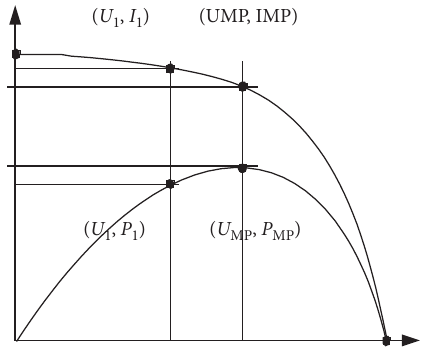
Figure 4: I - U curve and P - U curve of PV